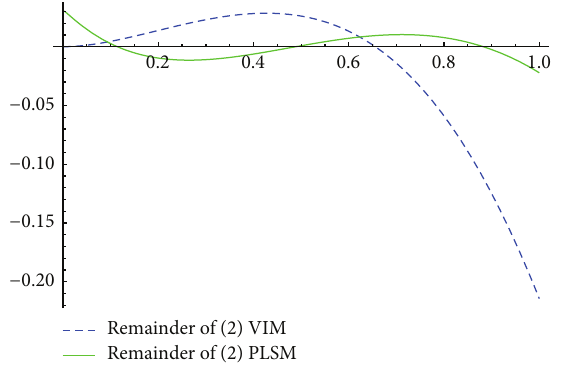
Figure 4: The remainders corresponding to the second equation for the case 𝛼 1 = 𝛼 2 = 0.98 .